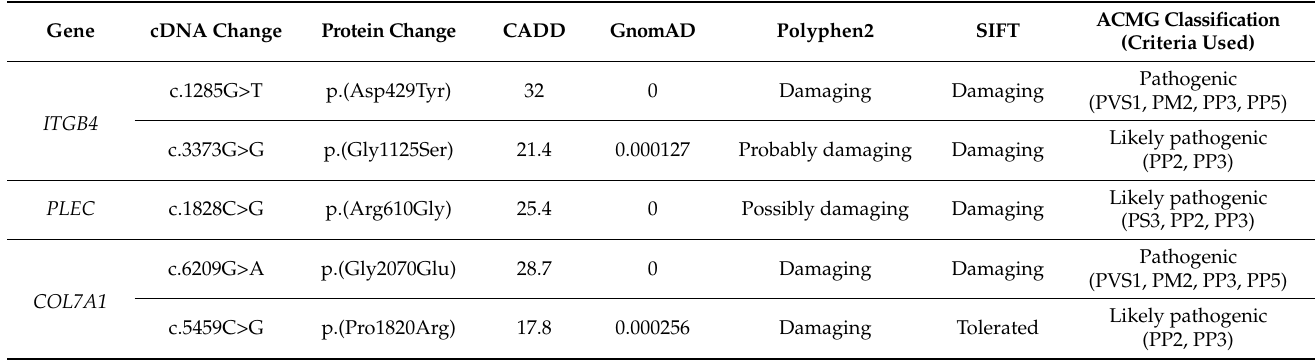
Table 2. Epidermolysis bullosa-causing genes, identified variants and their ACMG